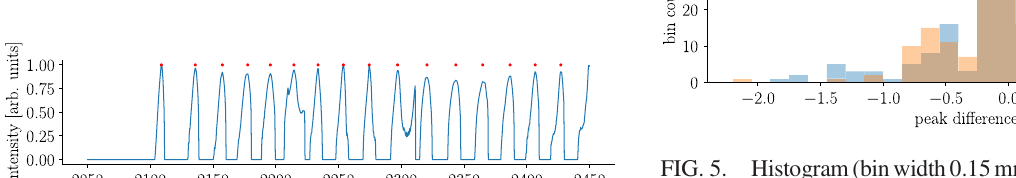
FIG. 5. Histogram (binwidth0.15mm)ofthechanges inthe peak positionsfortheRRLprobecomparedtothereferencemeasurement in Fig. 4 for a lower ( 58 μ A, μ ¼ − 0 . 1 mm, σ ¼ 0 . 5 mm) and higher ( 108 μ A, μ ¼ 0 . 0 mm, σ ¼ 0 . 6 mm) intensity. The mean absolute error (MAE) taking both intensities is 0.4